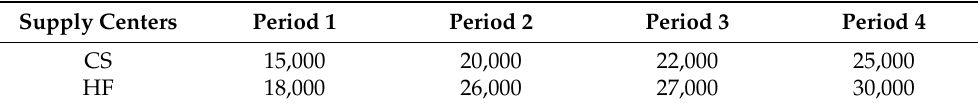
Table 6. Available inventory capacity of each supply center at the end of each time period (m 3 ).